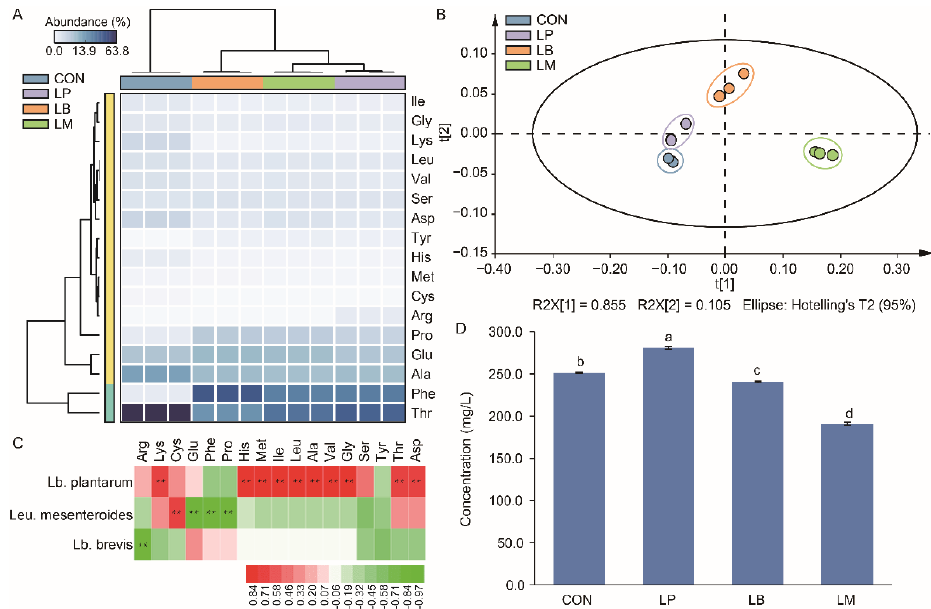
Figure 4. The heatmap ( A ), scatter plot ( B ), correlation analysis with LABs ( C ), and total concentration ( D ) of amino acid in Suancai fermented with different autochthonous LABs. Different letters represent significant differences ( p < 0.05). ** p < 0.01.